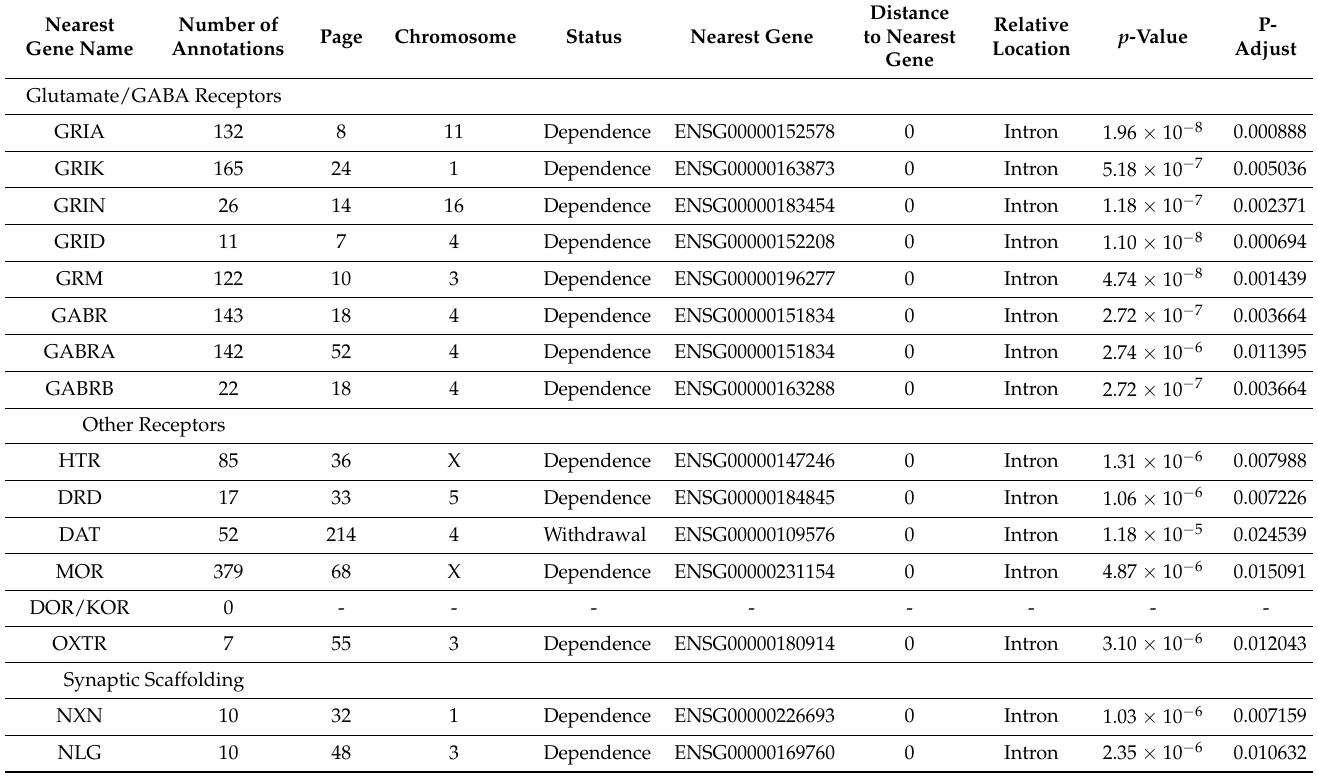
Table 9. Epigenomic Data for Key Synaptic EWAS Hits, Data from Schrott